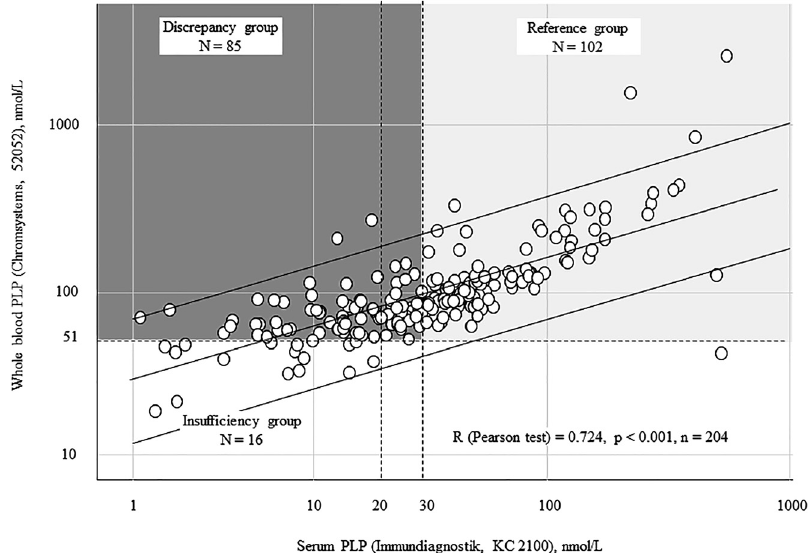
Figure 2: Scatter plot of serum PLP and whole blood PLP measured parallel in 204